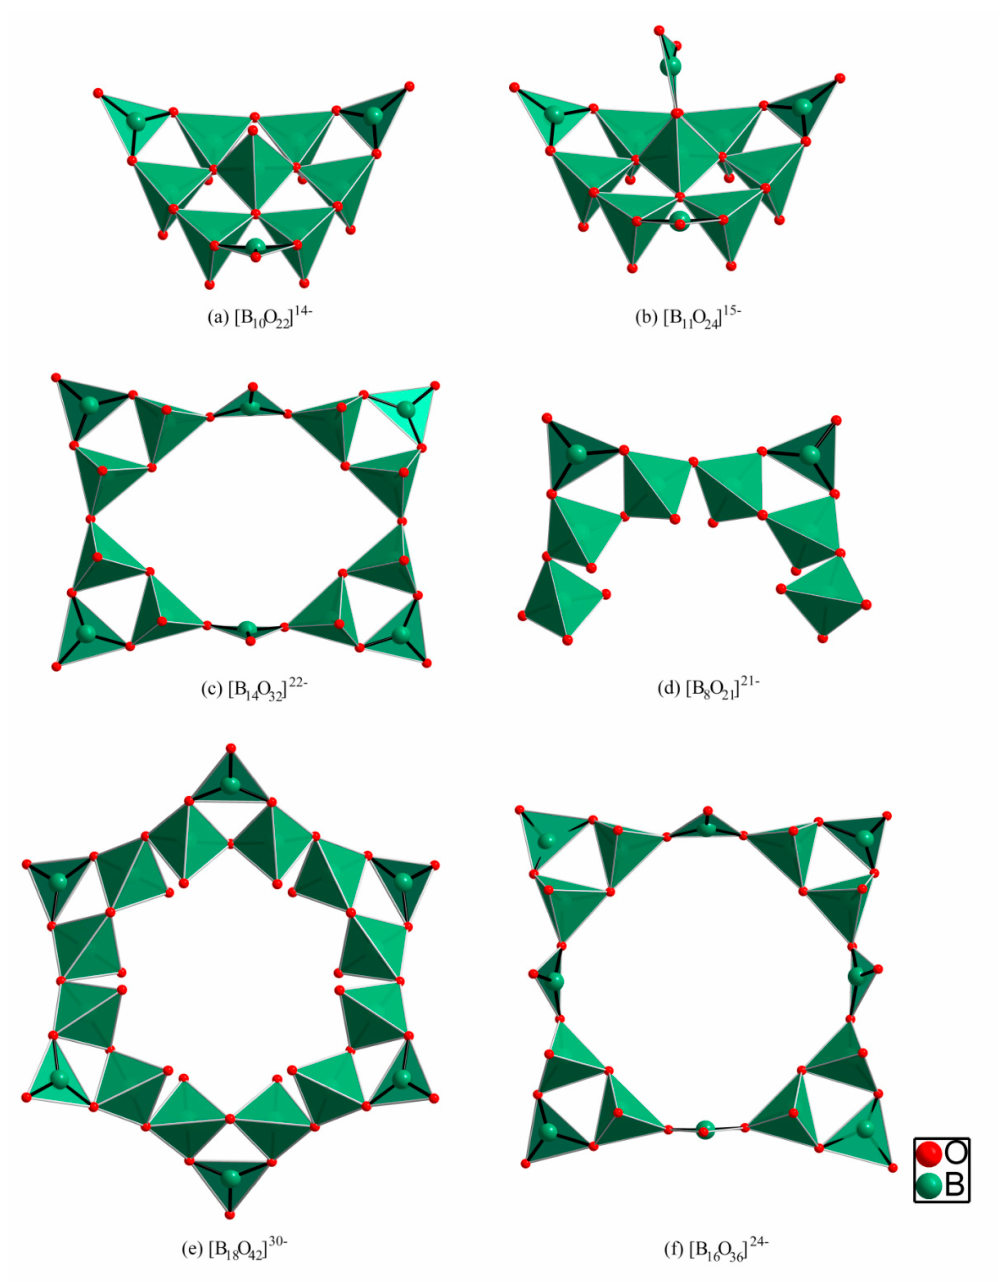
Figure 2. Polyhedral representation of the borate